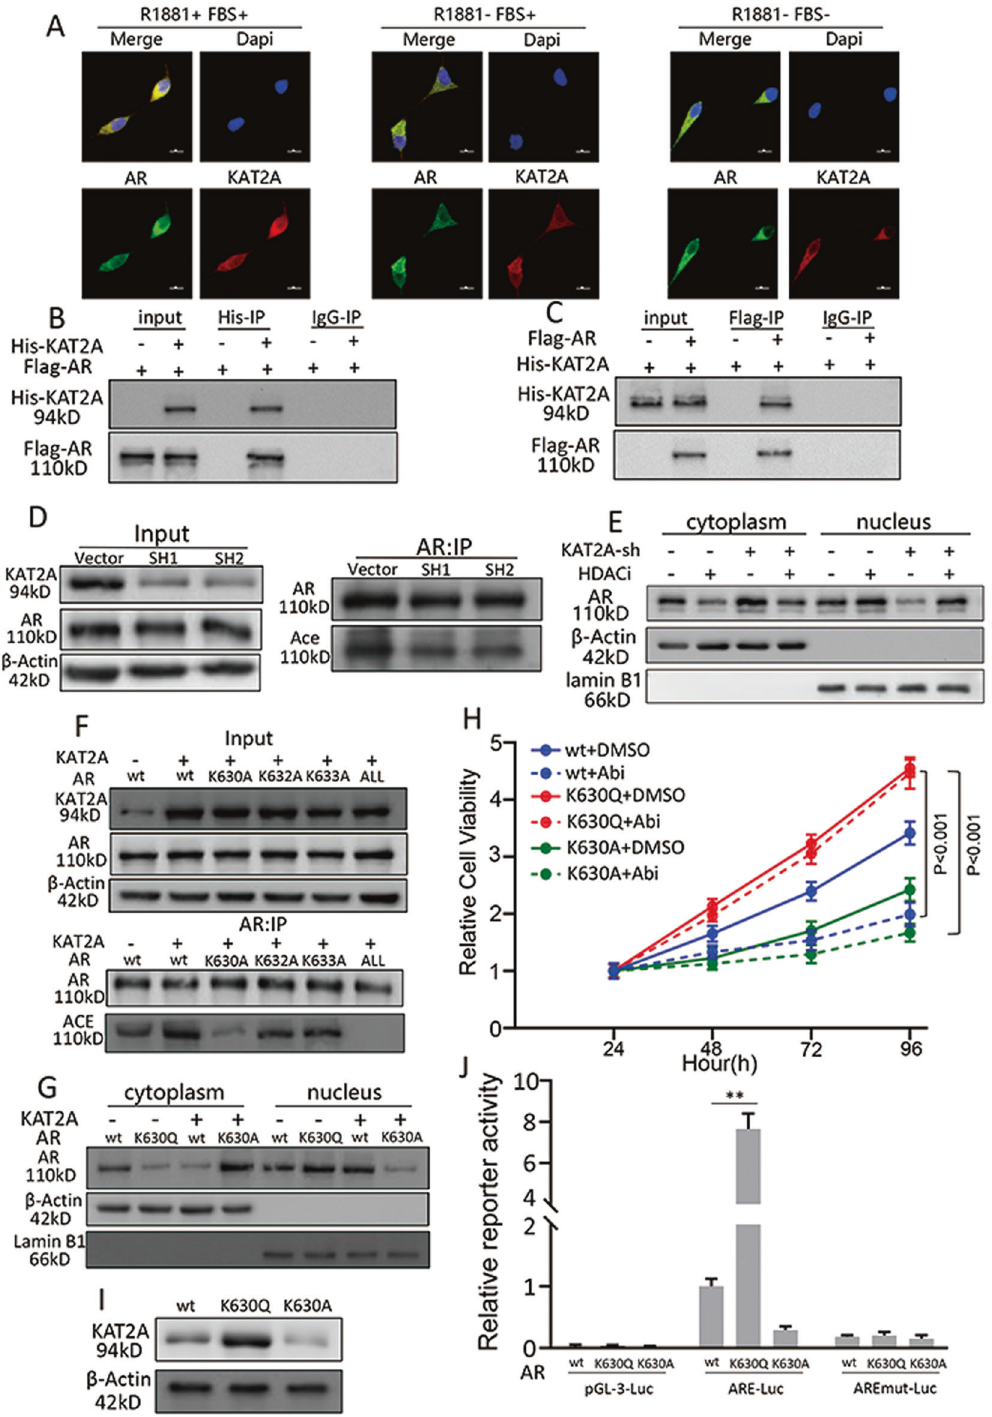
Fig. 5 KAT2A facilitates AR translocation from the cytoplasm to the nucleus by acetylating AR at K630, and AR can increase the expression of KAT2A. A Demonstrative immuno fl uorescence images of KAT2A and AR protein localisation in C4-2-AbiR cells. B, C PC-3 cells were transiently transfected with His-KAT2A and Flag-AR for 2 days, and whole-cell lysates were immunoprecipitated with anti-His ( B ) or -Flag ( C ) antibodies and blotted with the corresponding antibodies. D Acetylation level of AR in C4-2-AbiR stably transfected with sh-KAT2A detected by pan-acetylation antibody after immunoprecipitation by AR antibody from cell lysates. E Aggregate of AR in cytoplasm or nucleus in C4-2-AbiR stably transfected with sh-KAT2A or vectors with or without HDAC inhibitor were extracted and detected. F AR of wild-type, K630A, K632A, K633A were constructed and co-expressed with oe-KAT2A or vectors in AR negative PC-3 cell line and acetylation of AR were detected after immunoprecipitation by AR antibody. G AR in cytoplasm and nucleus were extracted respectively after AR of wild-type (wt), K630Q, K630A were constructed and expressed. H Relative cell viability of PC-3 cell line stably transfected with AR of wt, K630Q or K630A with or without abiraterone. I Protein level of KAT2A were detected in PC-3 stably transfected with AR of wt, K630Q, K630A. J Dual-luciferase assays performed using the control pGL3, ARE, and AREmut constructs in the presence of AR of wt, K630Q, K630A.* p < 0.05, ** p <